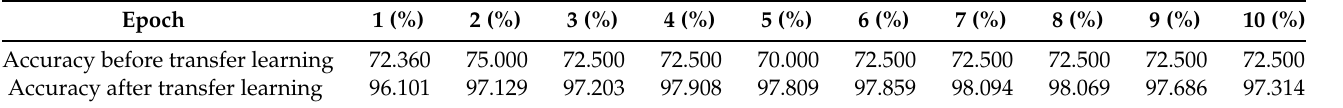
Table 7. Accuracy comparison table before and after LeNet5 transfer